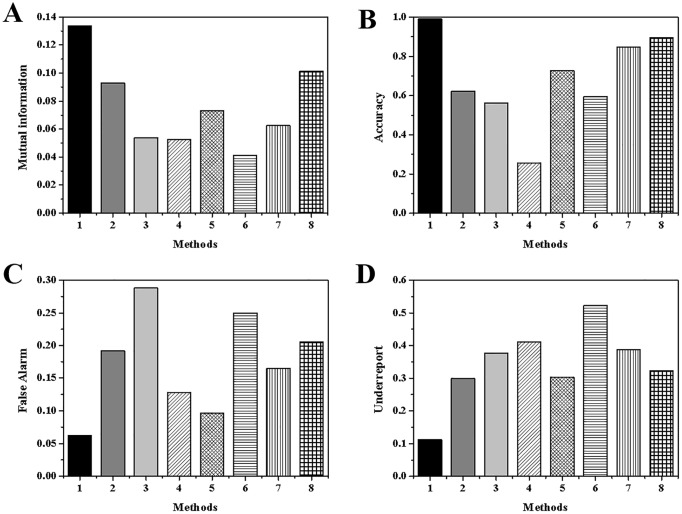
Comparison of mutual information, accuracy, false positive rate, and false negative rate of different algorithms.